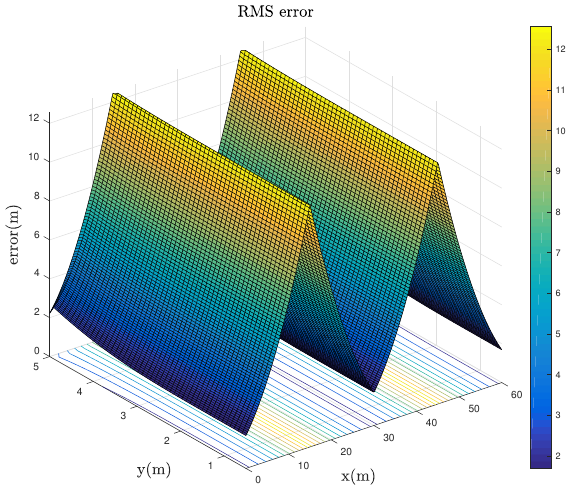
Figure 2. RMS error of VLP across the road using